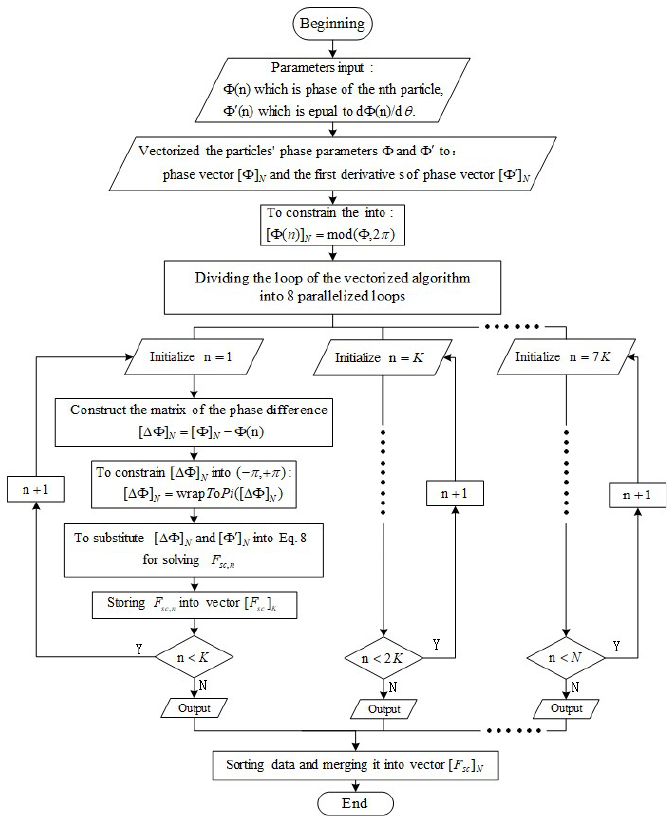
Figure 8. The schematic diagram of the CPU-parallelized algorithm.